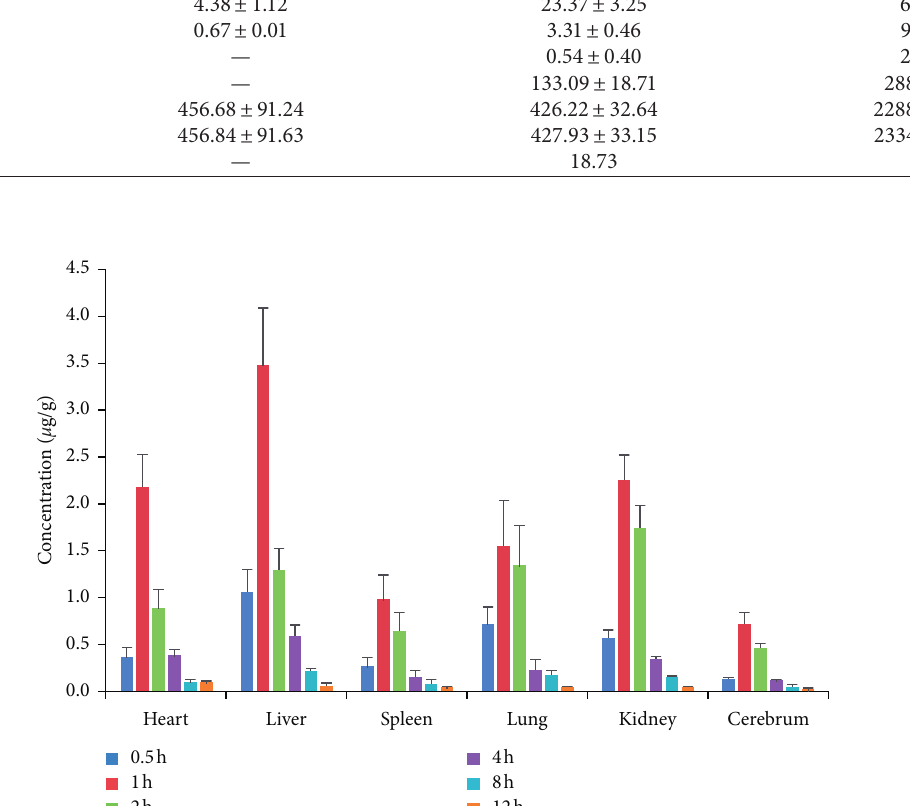
Figure 4: The concentration-time profile of Schisandrol B in tissues following oral administration ( n � 3).